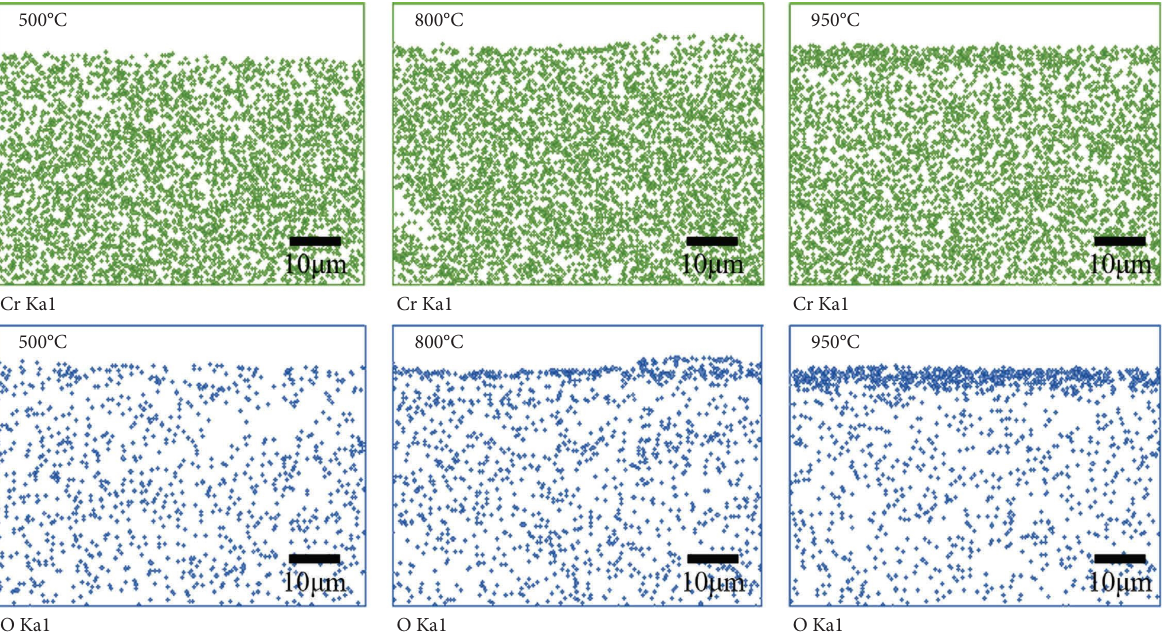
Figure 5: EDS analysis result of oxygen and chromium elements in Incoloy 800H under impure helium at 500 ° C, 800 ° C, and 950 °